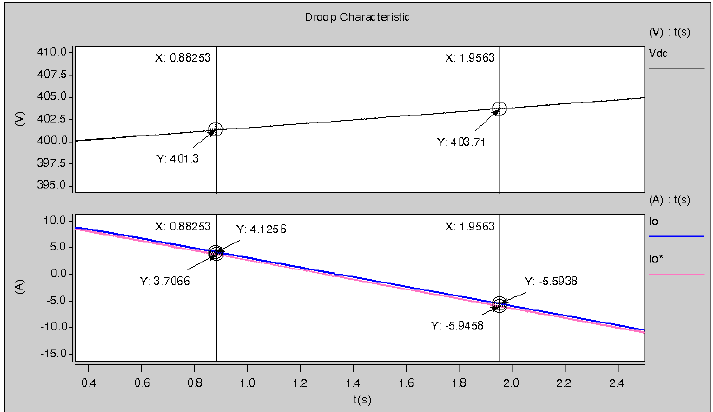
Figure 14. Droop characteristics.